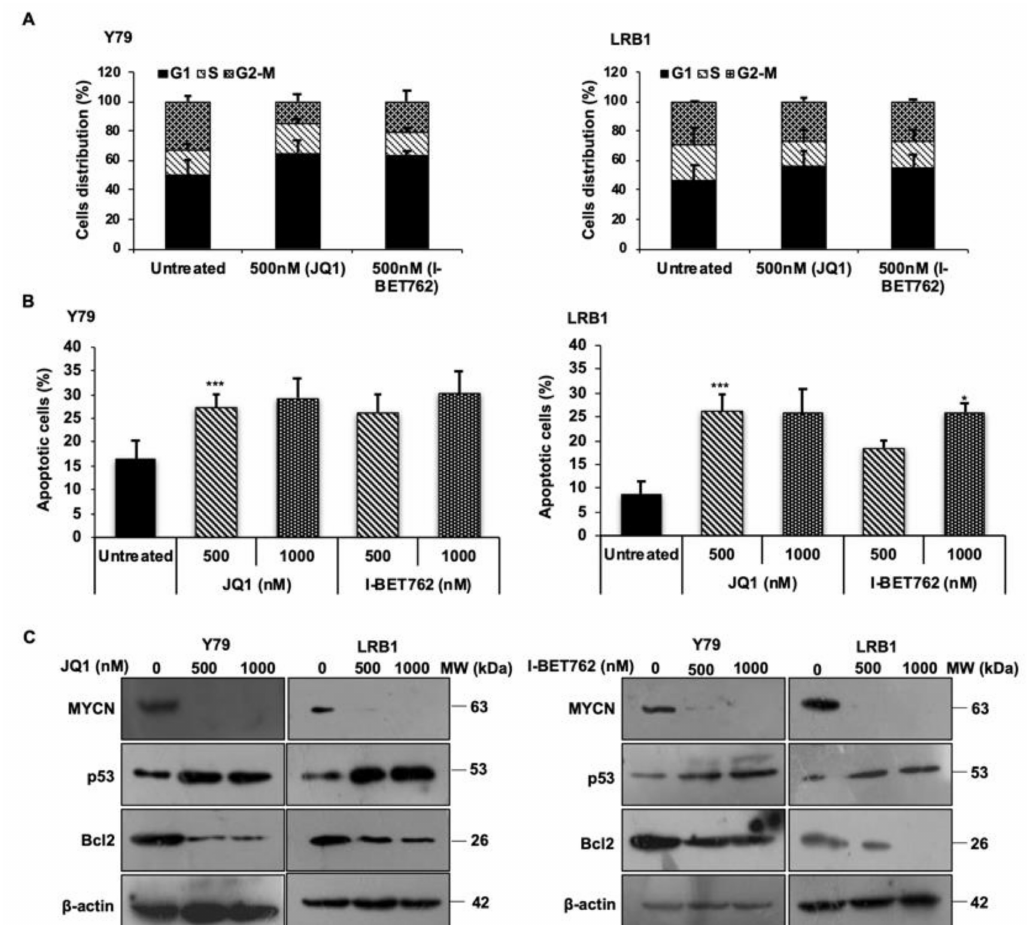
Figure 3. MYCN inhibition promotes cell cycle arrest at G0/G1 phase and induces apoptosis in RB cells. ( A ) Fraction of cells accumulated in each phase of the cell cycle after treatment with JQ1 and I-BET762 in Y79 and LRB1 cells. ( B ) Total apoptosis in Y79 and LRB1 cells treated with JQ1 and I-BET762. ( C ) Protein expression levels of MYCN , Bcl-2 and p53 upon inhibition with JQ1 and I-BET762 in Y79 and LRB1 cells. The error bars represent the standard error of mean (* p < 0.05 vs. untreated, *** p < 0.001 vs.